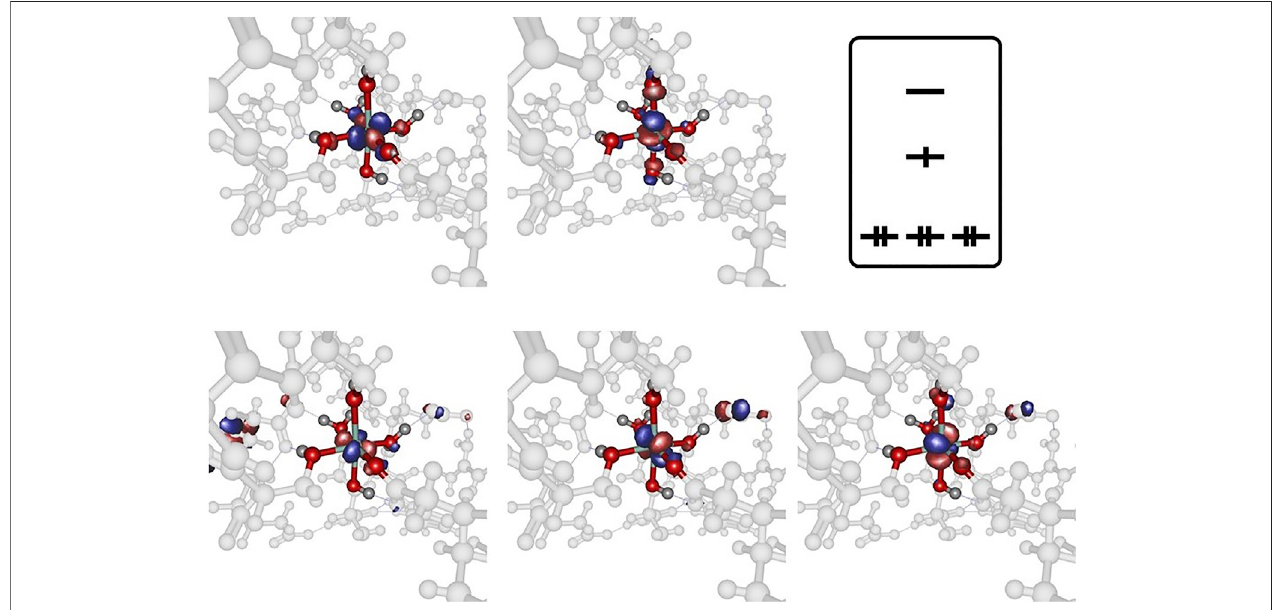
FIGURE 5 | Frontier orbitals for the Co 2+ model complex obtained at the B3LYP/6-31G* level of theory and sketched population scheme. Only orbitals with signi fi cant Co contribution are displayed. While the essential shape of the fi ve Co d-orbitals is conserved, substantial deformation and bending of the respective orbital orientation is apparent. The amino acid residues are shaded collectively in gray color for the sake of clarity.